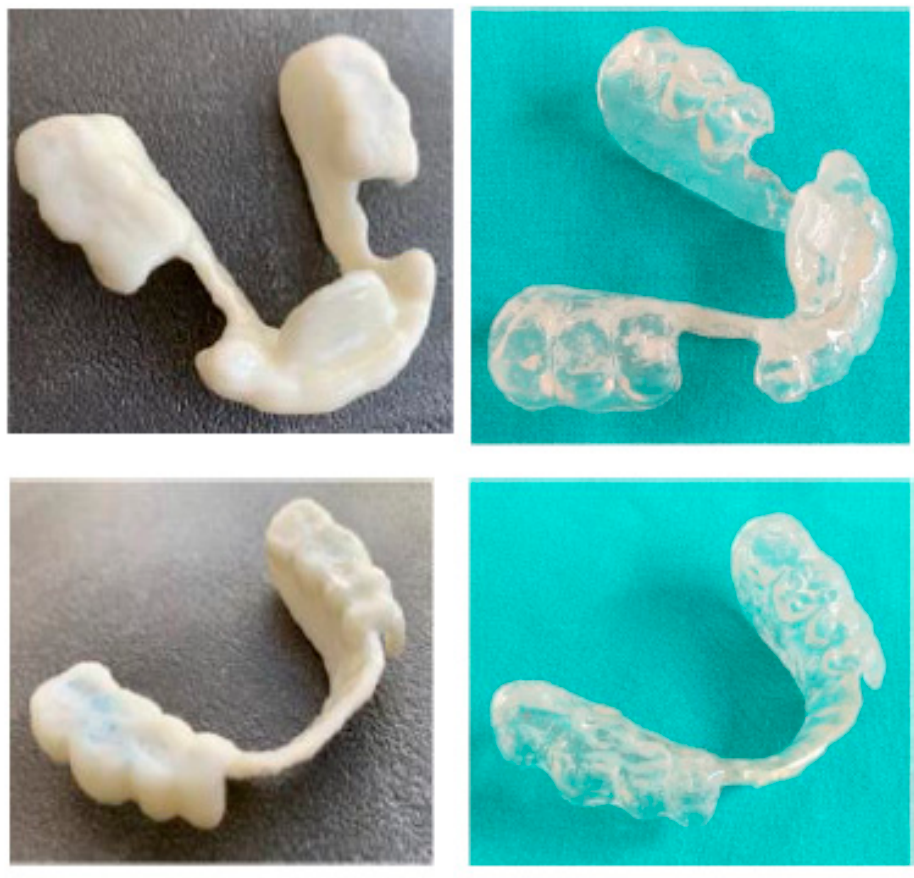
Figure 12. White or transparent material.